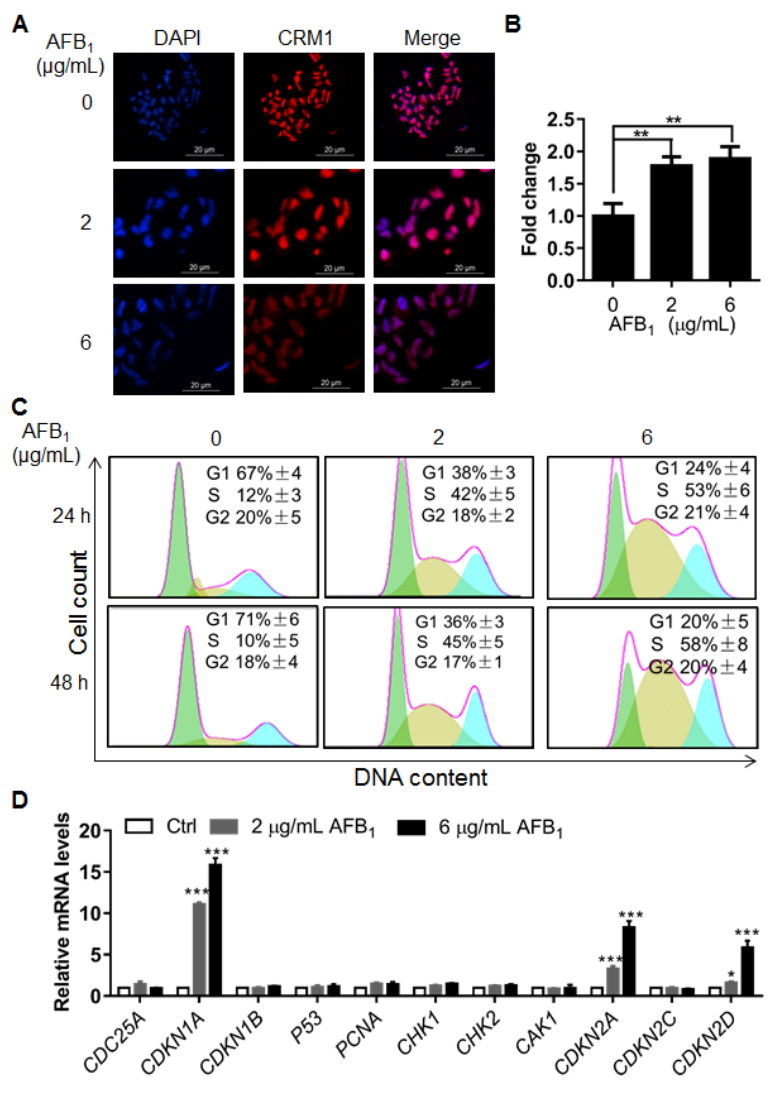
Figure 5. The cell cycle is arrested in S phase upon treatment with AFB 1 in IMR-32 cells. ( A ) Representative immunofluorescence staining images of the nuclei of IMR-32 cells after 2 and 6 μg/mL AFB 1 treatment for 24 h. CRM1 was used to determine nuclear size. Blue colour: nucleus; Red colour: CRM1; ( B ) Quantification of nuclear size in panel A by ImageJ. ( C ) Cell cycle analysis of IMR-32 cells by flow cytometry following AFB 1 treatment. The data were analyzed with FlowJo software. ( D ) Fold changes in the mRNA levels of cell cycle-related genes in IMR-32 cells after exposure to 2 μg/mL or 6 μg/mL AFB 1 for 24 h. All of the mRNA levels tested were normalized to GAPDH . All experiments were performed in triplicate and the values represent the mean ± SD of three independent experiments. Statistical significance was defined as * p < 0.05, ** p < 0.01, or *** p < 0.001. 2.6. AFB 1 Induces Apoptosis